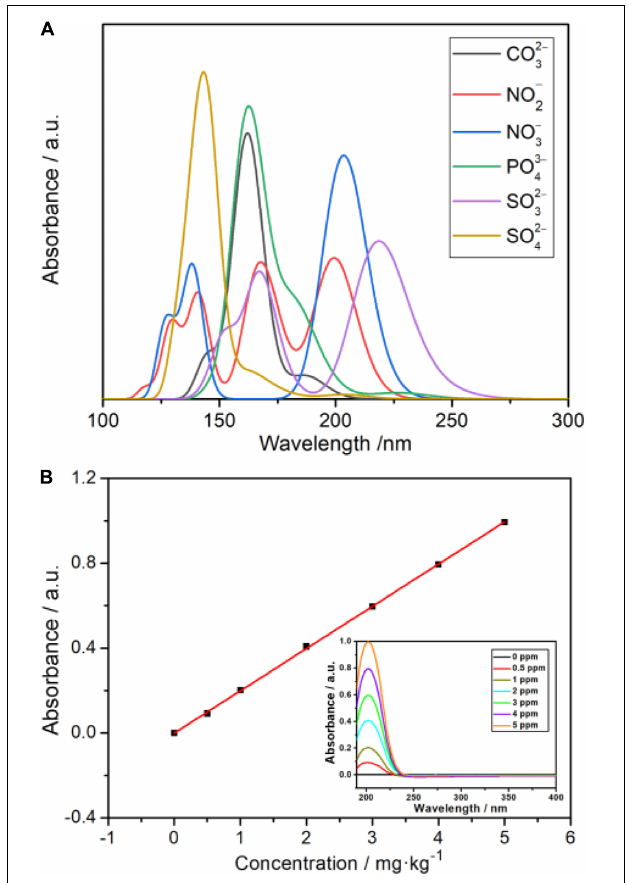
FIGURE 3 | (A) Absorbance of several ions in water from UV-Vis spectrophotometry. (B) Standard curves were made by UV-Vis spectrophotometry.